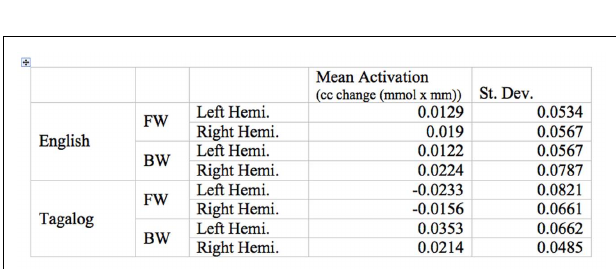
FIGURE 6 | Mean oxyHb activation for the target ROI across language, direction, and hemisphere.